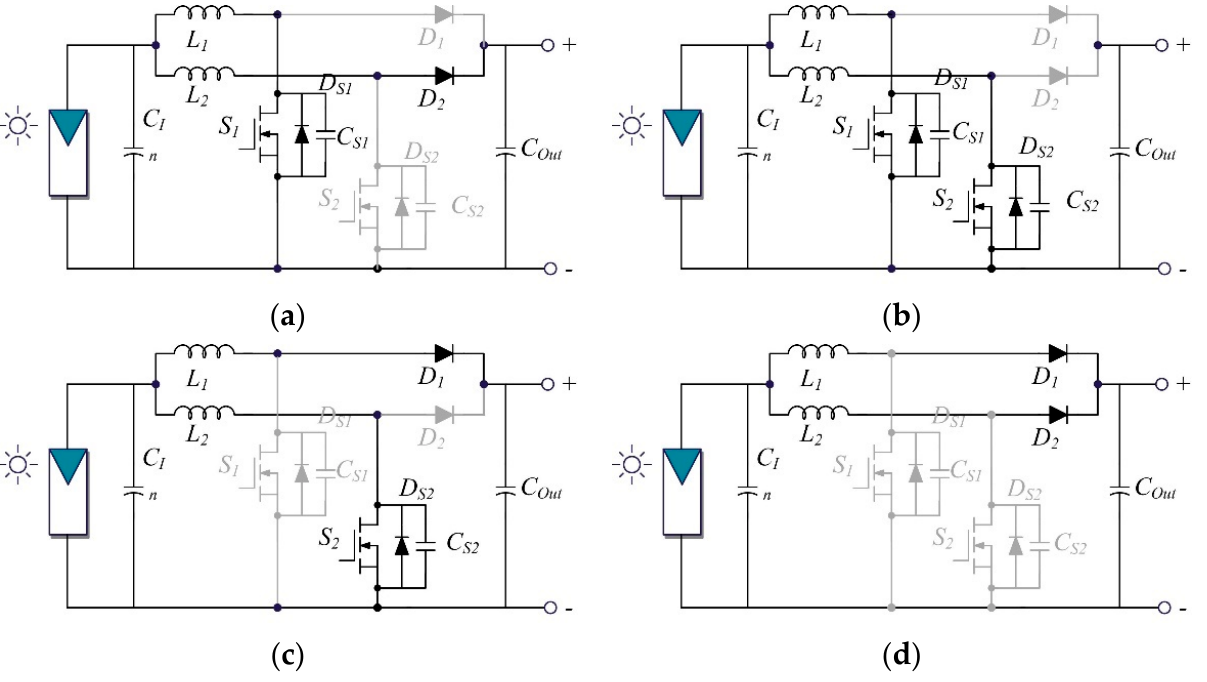
Figure 4. Operation modes of two − phase IBC: ( a ) Mode I; ( b ) Mode II; ( c ) Mode III; ( d ) Mode IV. Mode-I [t 0 ≤ t < t 1 ] : Figure 4a shows the equivalent circuit for this operation mode with S 1 turned on and S 2 turned off. In this switching interval, the current of inductor L 1 ( I L 1 ) is increased, and the inductor stores the energy. As I L 1 increases, the diode on the inductor path becomes reverse-biased, and the load is supplied by the energy stored